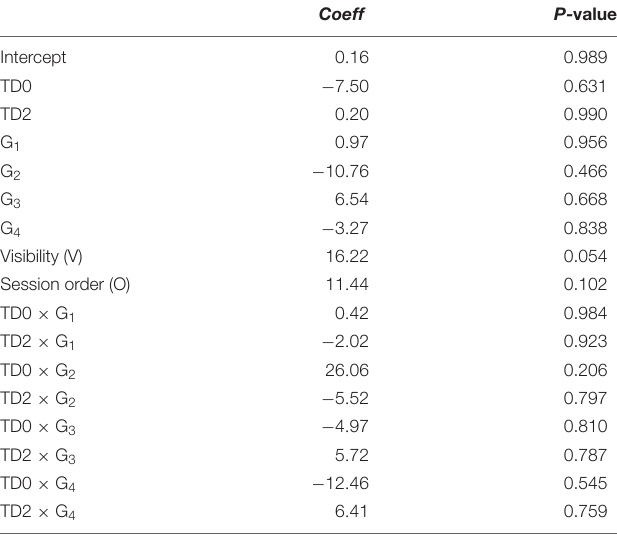
TABLE 5 | Effect of “catch trials” on timing